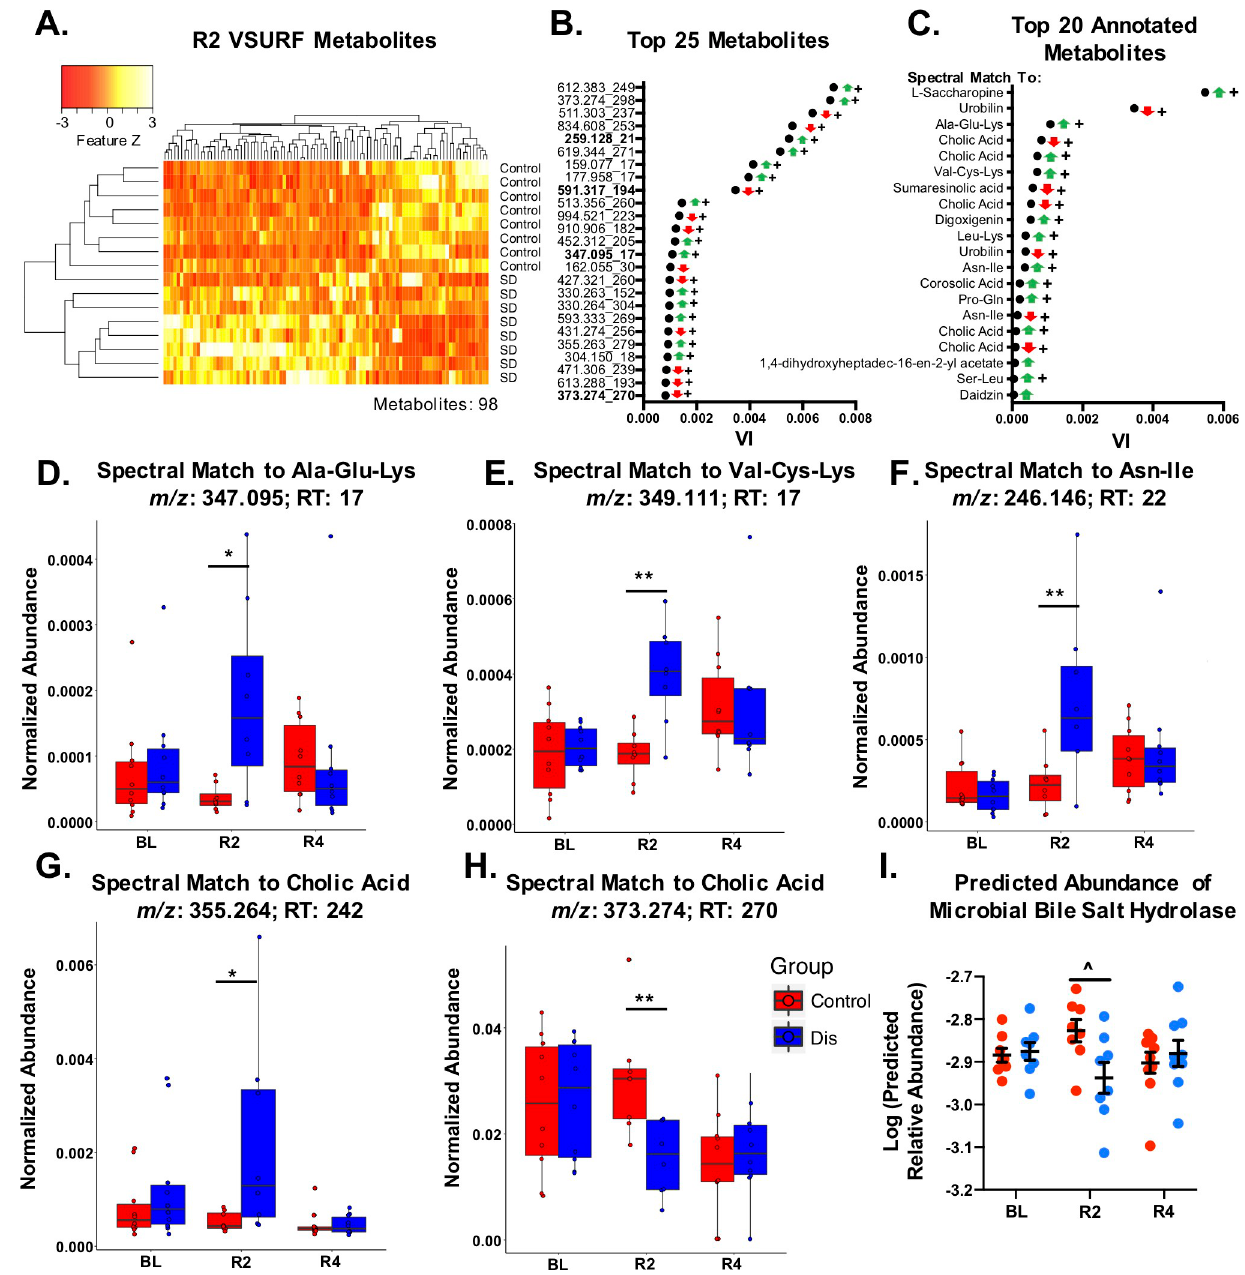
Fig 6. Metabolites that drive changes seen at day 2 post-sleep disruption. Variable Selection Using Random Forests (VSURF) was performed at the second day post-sleep disruption (R2) to identify metabolites that are the most important drivers (above a threshold variable importance) of separation between sleep-disrupted and control groups. A) Heatmap of the 98 suprathreshold metabolites. B) Variable importance scores of the top 25 suprathreshold metabolites ( m/z _RT), along with direction of change (arrows, green/up = increased in sleep disruption group, red/down = decreased in sleep disruption group). Bold indicates metabolites that were annotated using Global Natural Products Social Molecular Networking (GNPS). C) Top 20 annotated metabolites. Normalized abundance (peak intensity normalized to total ion count) of metabolites with spectral matches to D) Ala-Glu-Lys, E) Val-Cys-Lys, and F) Asn-Ile were increased at R2 but not at day R4. G,H) One metabolite with a spectral match to cholic acid was increased (G) and another was decreased (H) at R2. I) Inferred abundance of the microbial bile salt hydrolase gene (EC:3.5.1.24) was also reduced at R2. For (D-H), boxes indicate median, 25 th and 75 th quantiles; whiskers indicate 2 � IQR from edges of box. For (I), data represent mean ± SEM. Abbreviations: BL, baseline; R2, day 2 post-sleep disruption; R4, day 4 post-sleep disruption; Dis, Sleep Disruption; VI, variable importance; m/z , mass to charge ratio; RT, retention time (seconds). n = 8-10/group. +FDR < 0.1, � p < 0.05, �� p < 0.01 (Wilcoxon-Rank Sum test); ^FDR < 0.1 (DESeq2).